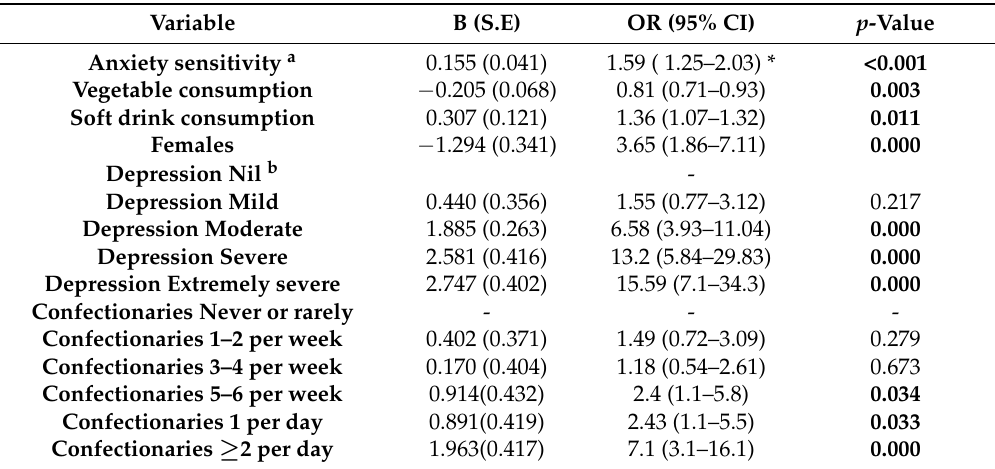
Table 3. Predictors of severe food addiction ( n =